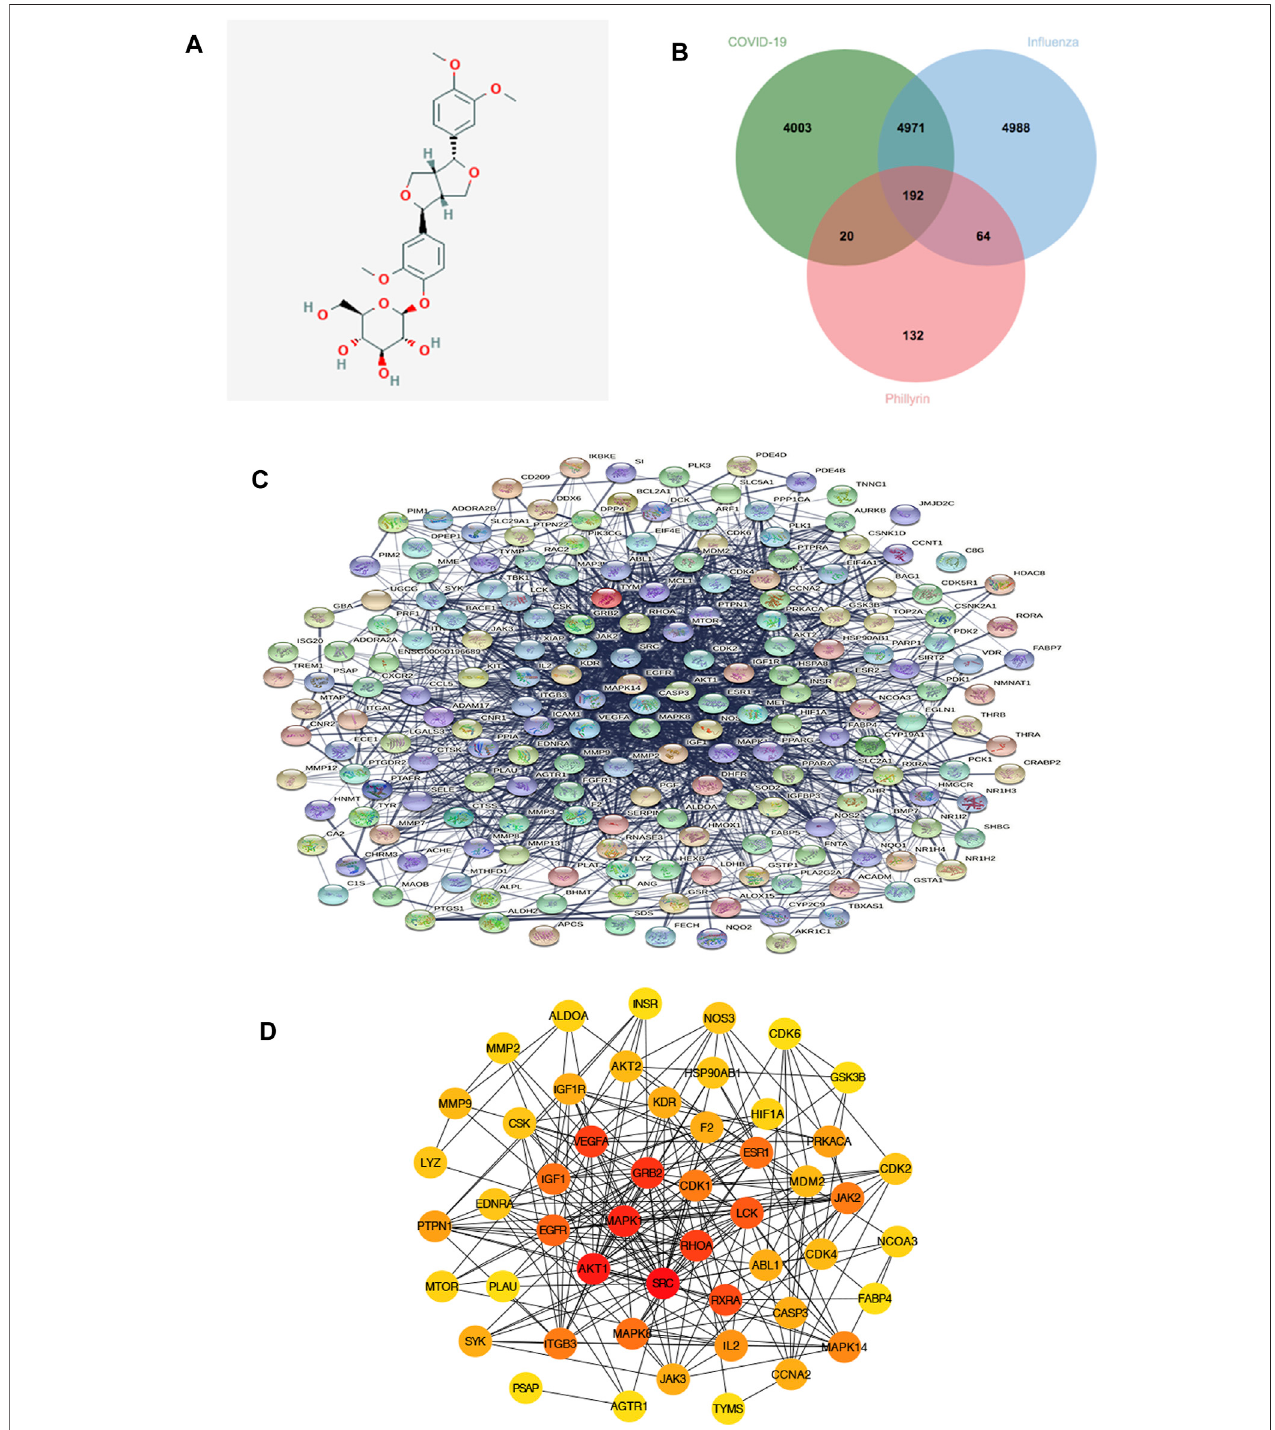
FIGURE2| Protein-proteininteraction(PPI)networkofphillyrinagainstin fl uenzaandCOVID-19. (A) Thestructureofphillyrin. (B) Theintersectionofphillyrintargets and disease targets. (C) 192 relevant overlapping genes. (D) The top 50 genes by degree ranking in the network.